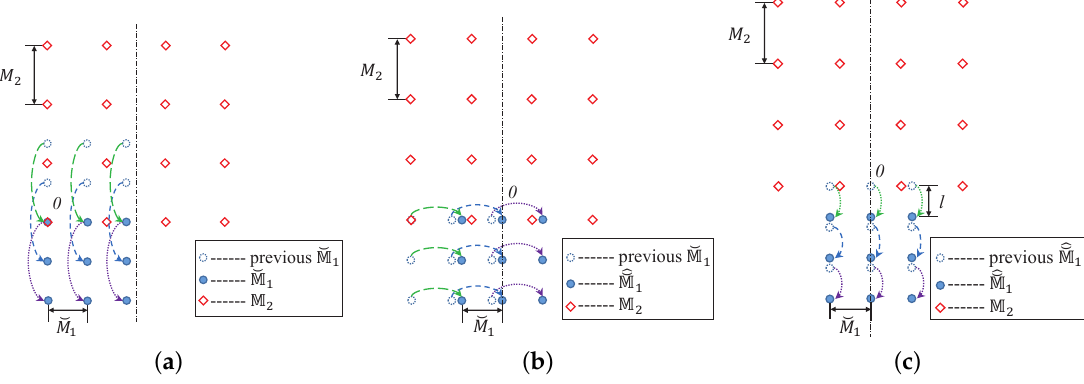
Figure 5. Translation process of the coprime array with two separated subarrays (CATSS) configuration, where M 1 = 4, M 2 = 3, and p = 2. ( a ) Step 1: Move ˘ M 1 by ( M 2 − 1 ) ˘ M 1 vertically. ( b ) Step 2: Move ˘ M 1 horizontally to make the whole array bilaterally symmetrical. ( c ) Step 3: Move